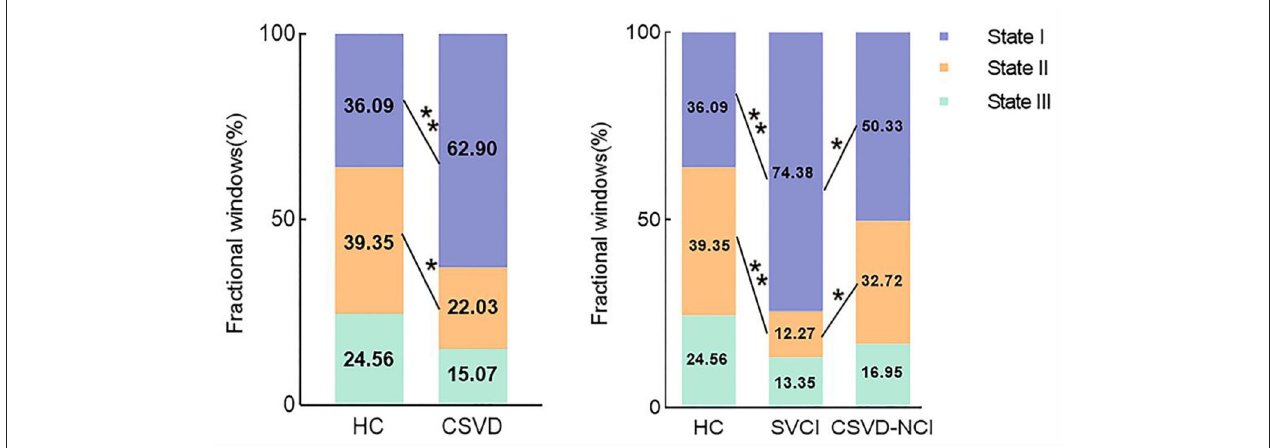
FIGURE 2 | Comparison of the fractional windows in each state between the CSVD and HC groups as well as among the CSVD subgroups by GLM. GLM, general linear model. * P < 0.05, ** P < 0.01.